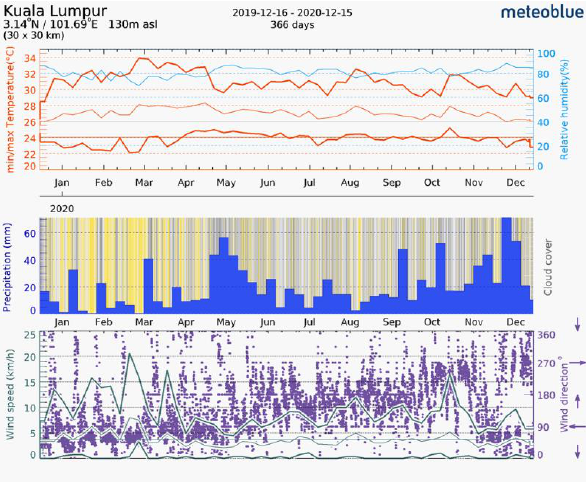
Figure 5. Historical weather data in Kuala Lumpur from December 2019 to 2020 [27].